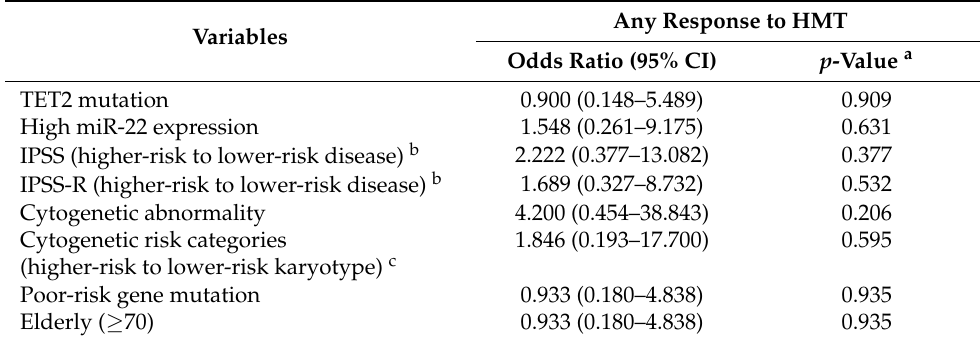
Table 5. Association of various clinical factors with overall response to hypomethylating